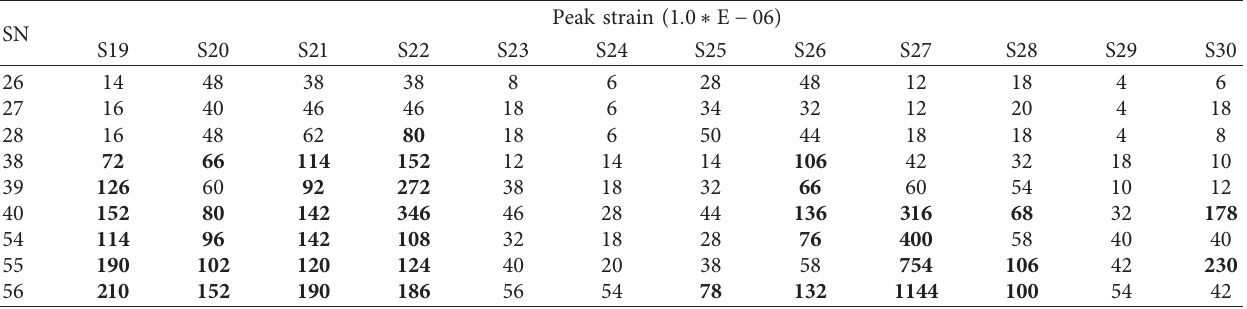
Figure 21: Peak strains of the concrete wall. (a) Sequence number from 26 to 28. (b) Sequence number from 38 to 41. (c) Sequence number from 54 to 56. Table 8: Peak strain values of the concrete